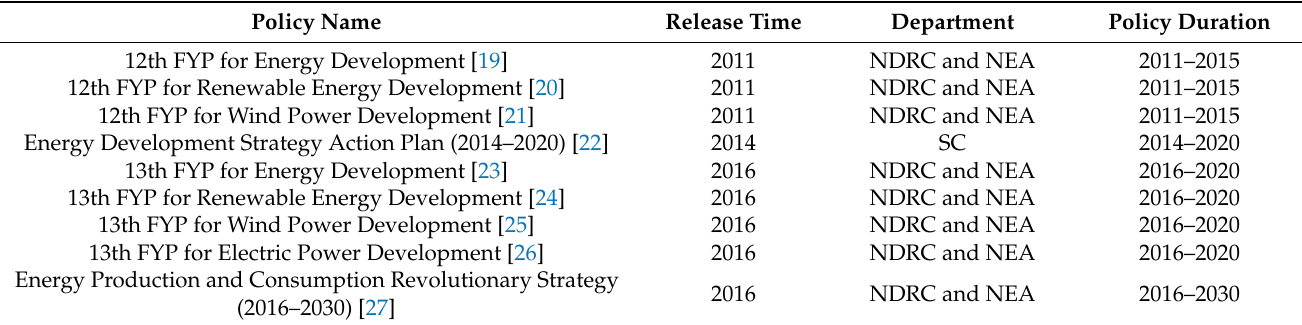
Table 2. Main development planning policies in